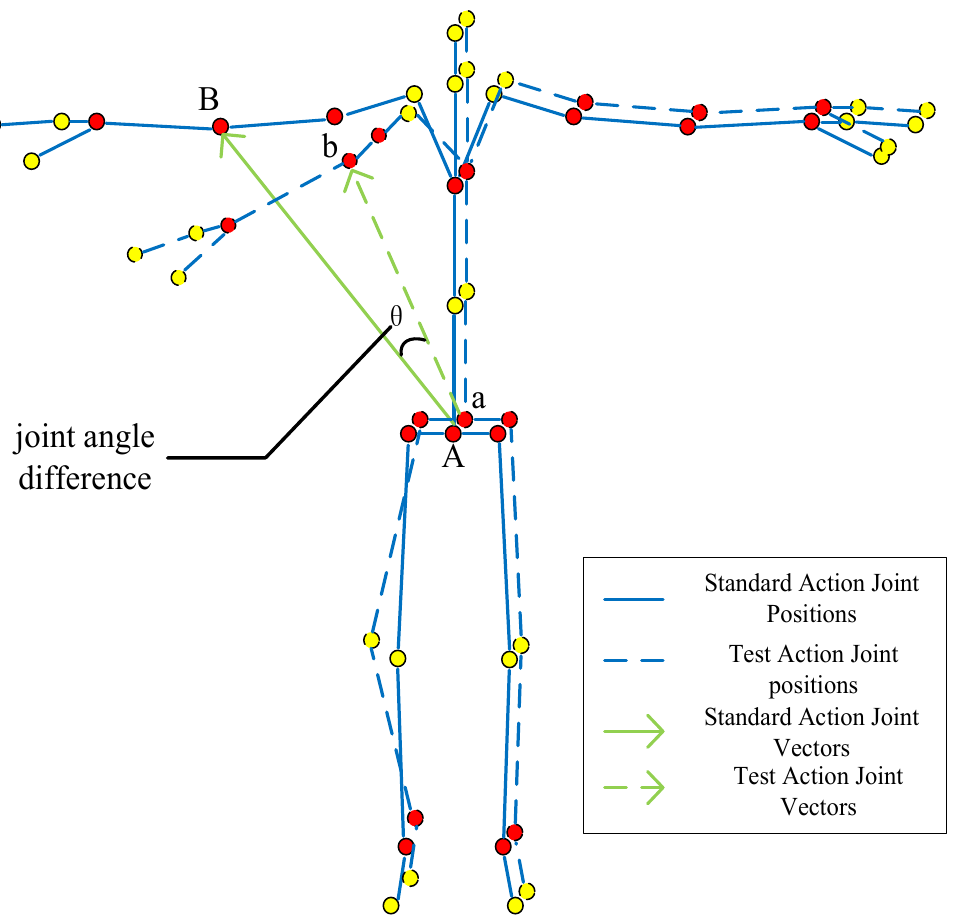
Figure 7. Action angle feature extraction (The red dots are the selected bone joint, and yellow dots are bone joint points that do not need to be selected; The letters correspond to Table 1 and Figure 1).